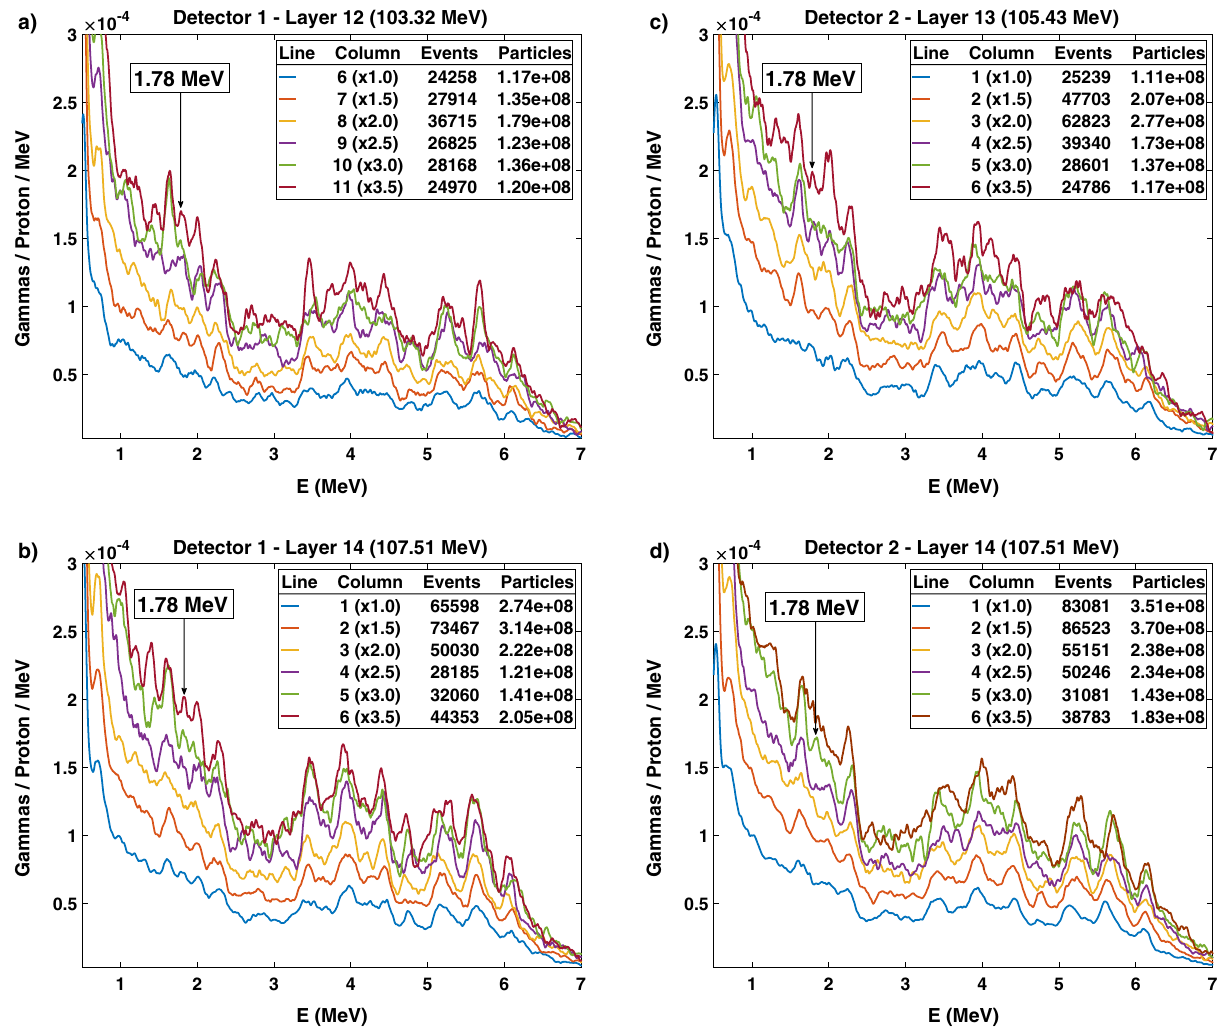
Figure 5. Energy spectra from the irradiation of the prostate phantom according to an anterior proton plan overlapping with the ERB. ( a,b ) Detector 1 detects the prompt gammas emitted from the irradiation of IELs 12 and 14. ( c,d ) Detector 2 detects the prompt gamma emitted from the irradiation of IELs 13 and 14. The plots are reordered into columns such that the central columns present a silicon energy line of 1.78 MeV. Detectors 1 and 2 detect the columns to the left and the right in the BEV, respectively, with higher sensitivity. For both detectors, the central columns, despite the lower counts due to attenuation, present silicon energy lines of 1.78